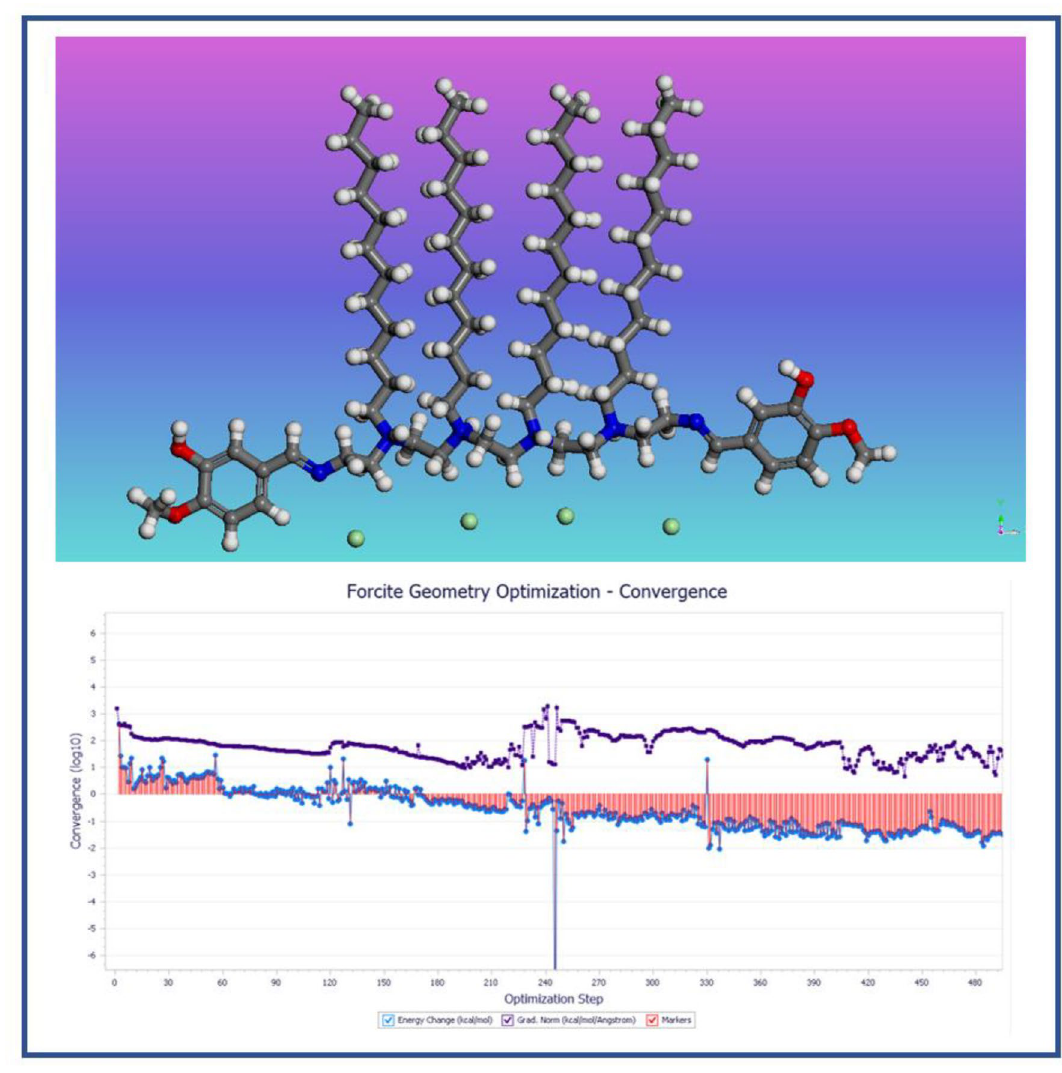
Figure 9. Optimized geometry of the investigated CS4 compound.